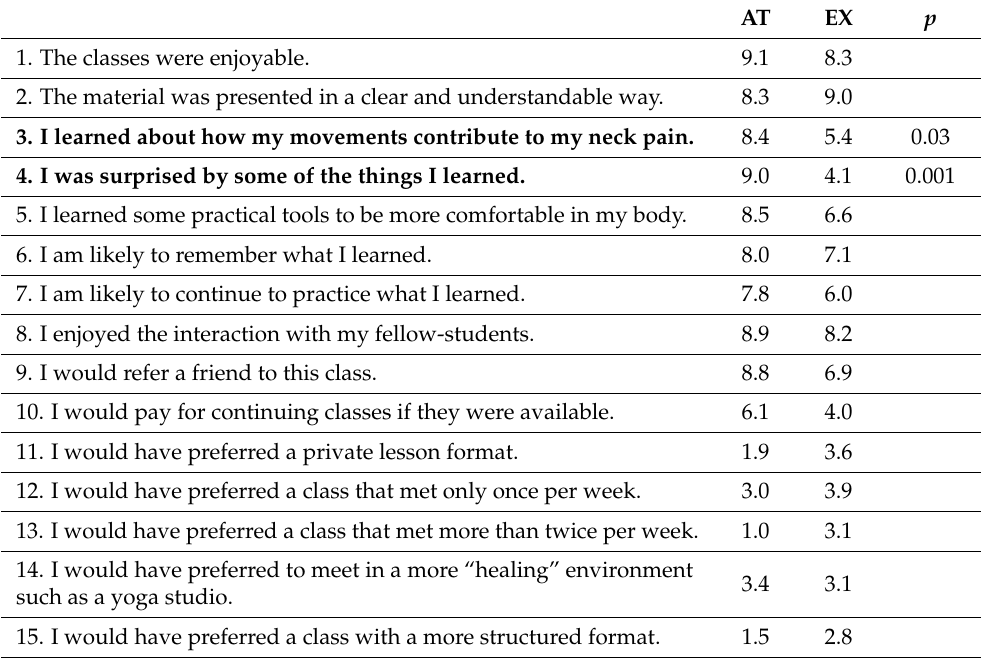
Table 2. Average rating for survey responses at second post-test .